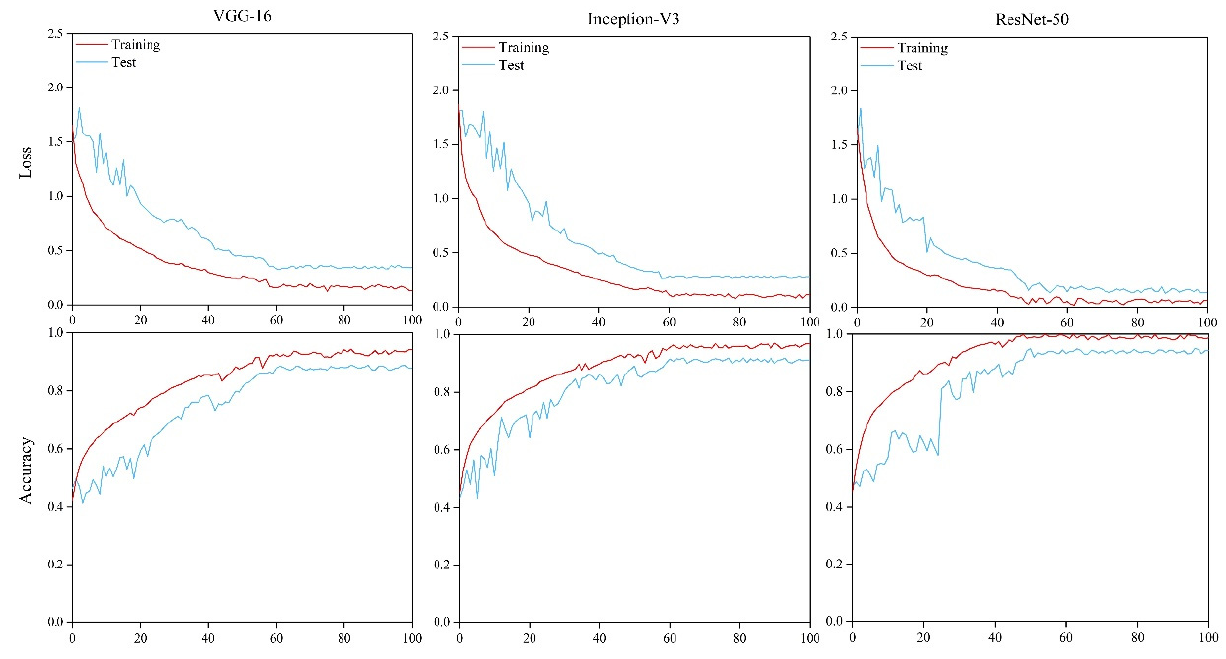
Figure 13. The confusion matrices of the three algorithms through RGB images. Types of lodging extents: NL is non-lodging, ML is moderate lodging, SL is severe lodging.